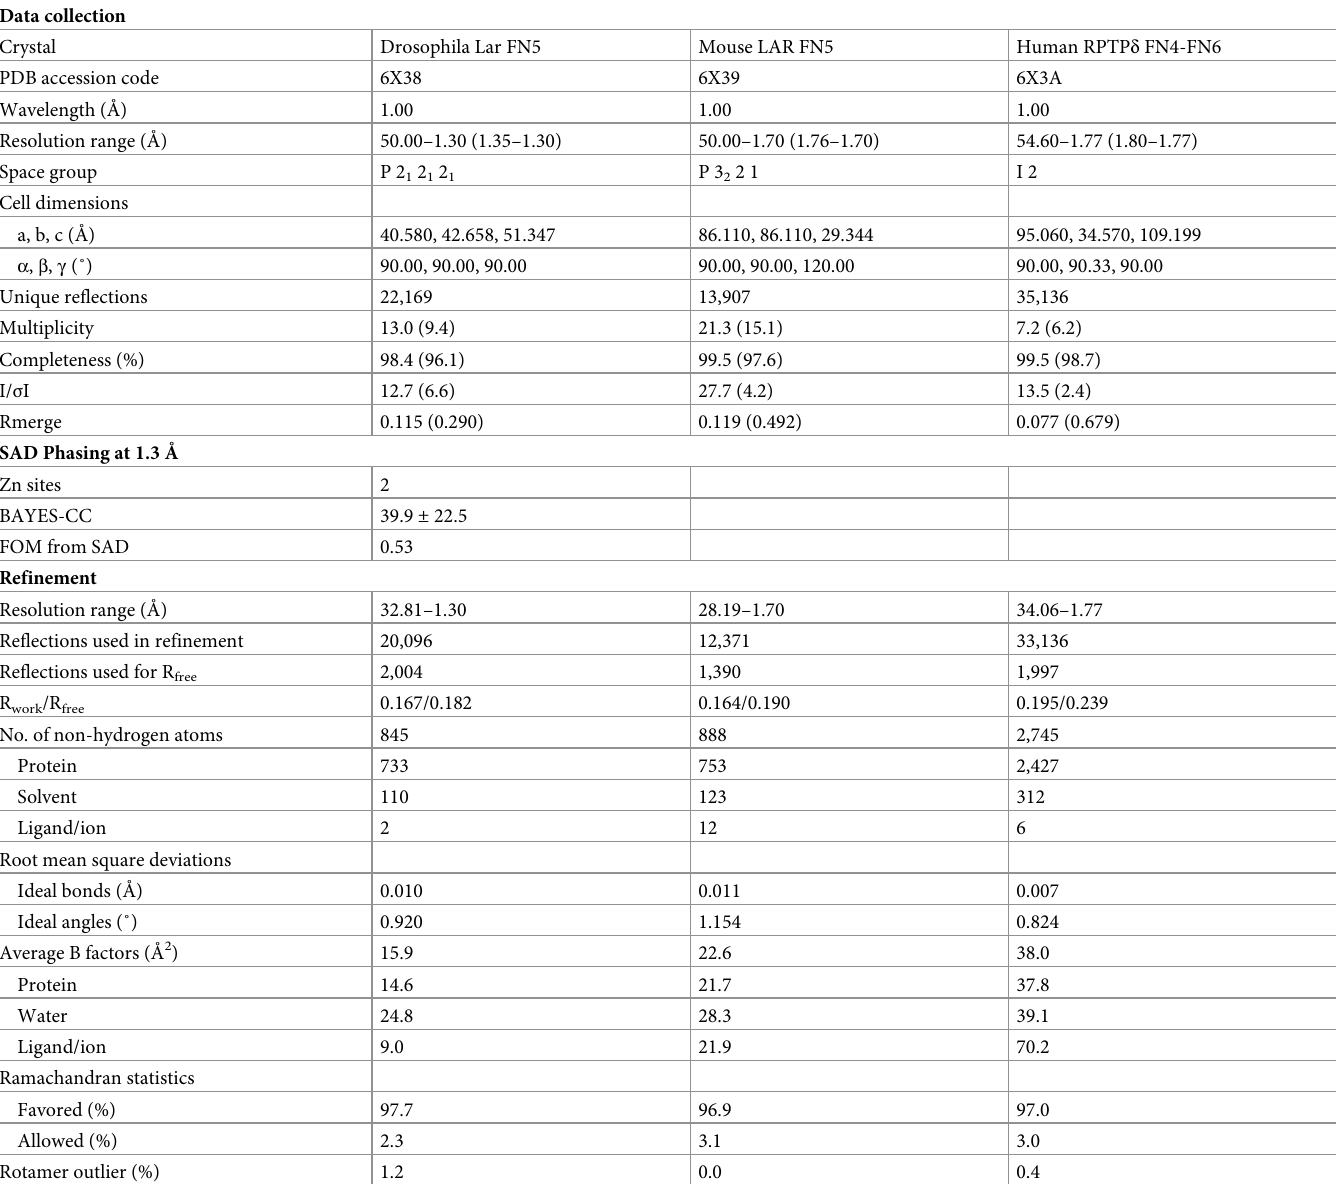
Table 2. Crystallographic data and refinement